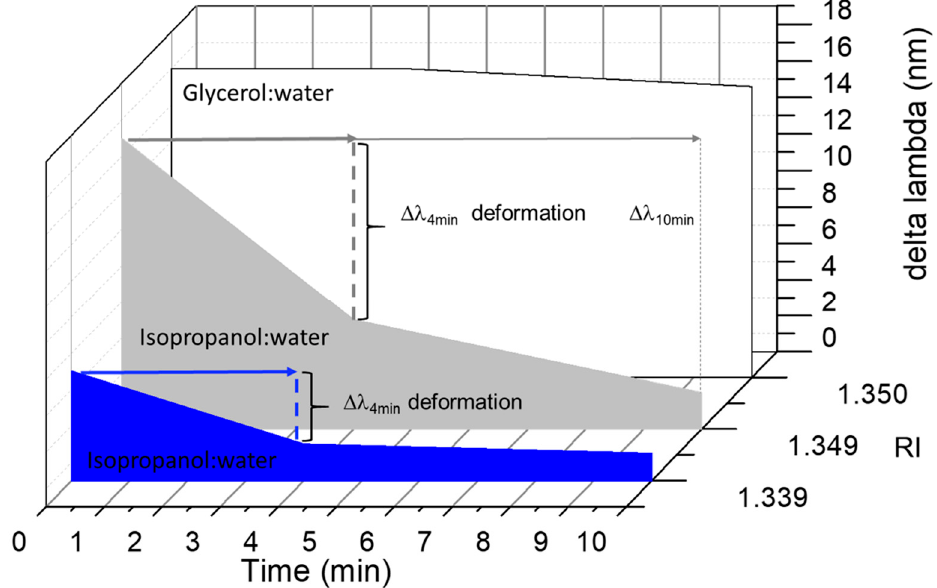
Figure 5. The MathMaterial sensor. Nanogel–POF was placed in contact with different environments: glycerol:water RI 1.350 (17% v / v glycerol) white; isopropanol:water RI 1.349 (20% v / v isopropanol) grey; isopropanol:water RI 1.339 (10% v / v isopropanol) blue. At time t = 0, the optical readouts ( Δ λ shift) informed us about the RI of the surrounding environments. Extending the meas- urements to longer incubation times (t = 4) permits monitoring deformations of the nanogel in terms